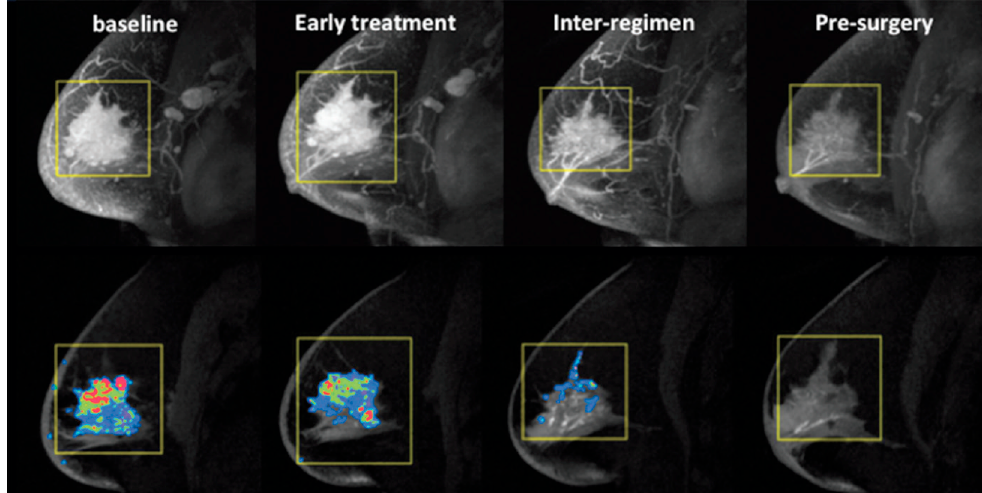
Figure 3. An example of using MRI functional tumor volume (FTV) to monitor a breast cancer patient during neoadjuvant chemotherapy. Shown here are maximum intensity projection images (top row) and corresponding FTV maps (bottom row) for a patient with an excellent clinical response. From left to right, FTV measurements were 48.5, 35.4, 5.6, and 0 cm 3 at baseline, early treatment, inter-regimen, and pre-surgery time points, respectively.